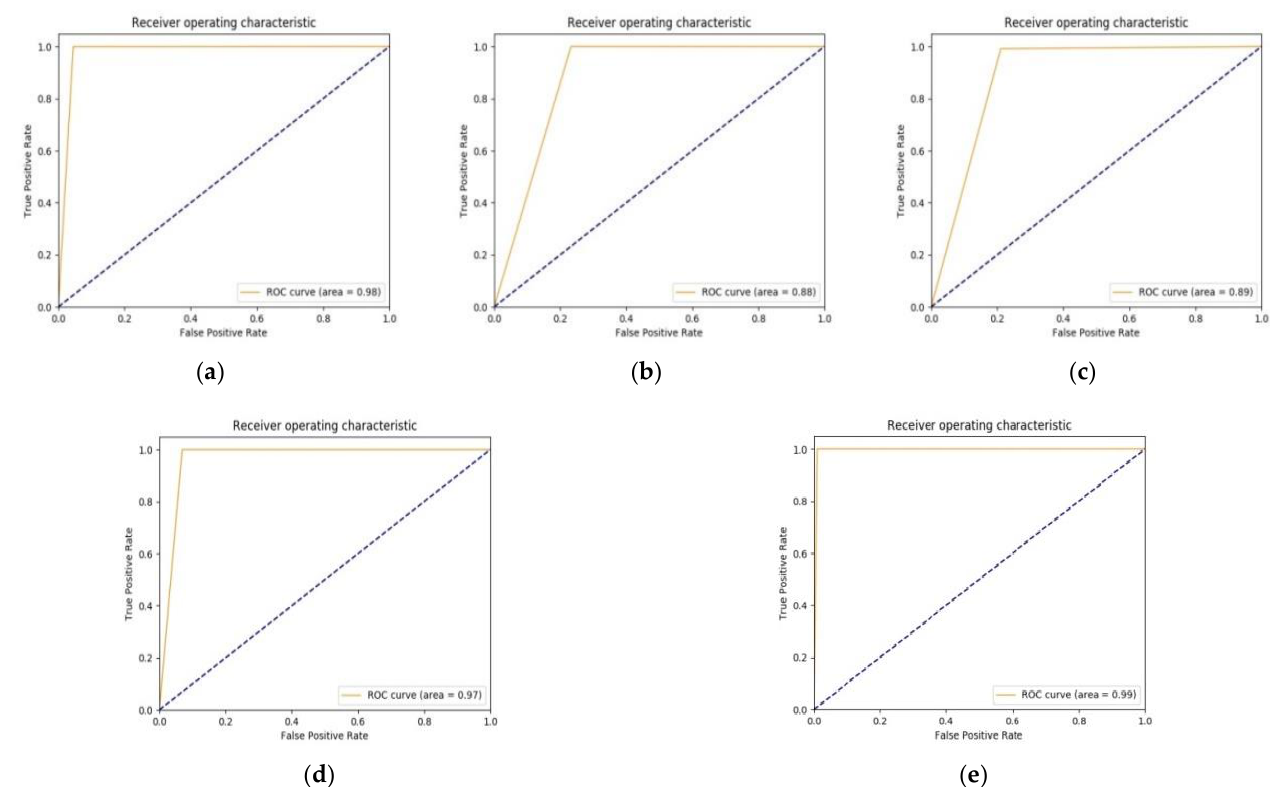
Figure 8. ROC curves for types of different customized IR-v2: ( a ) IR-v2 Type 1; ( b ) IR-v2 Type 2; ( c ) IR-v2 Type 3; ( d ) IR-v2 Type 4; and ( e ) IR-v2 Type 5.